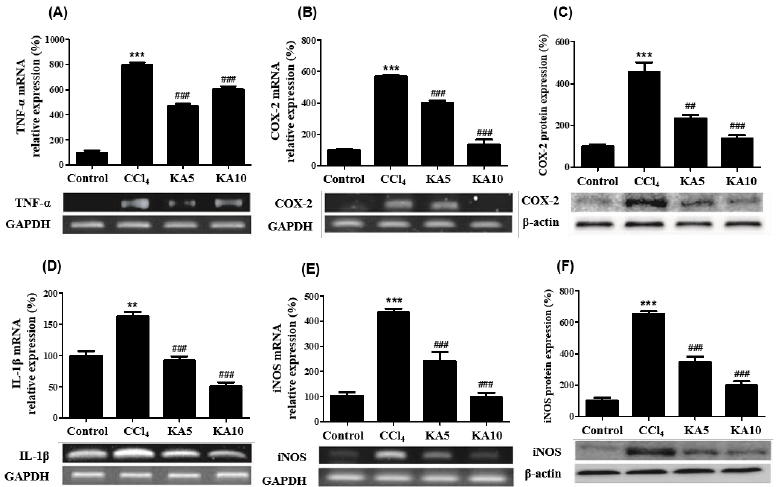
Figure 5. Effects of kaempferol on the pro-inflammatory mediators. The mRNA expression of TNF- α ( A ), IL-1 β ( D ), COX-2 ( B ), and iNOS ( E ) in rat liver intoxicated with CCl 4 was assessed using RT-PCR. Western blot analysis was performed to measure COX-2 ( C ) and iNOS ( F ) protein levels. Values are mean ± SE ( n = 3). ** p < 0.01 and *** p < 0.001 vs. the control group, and ## p < 0.01 and ### p < 0.001 vs. the CCl 4 group.